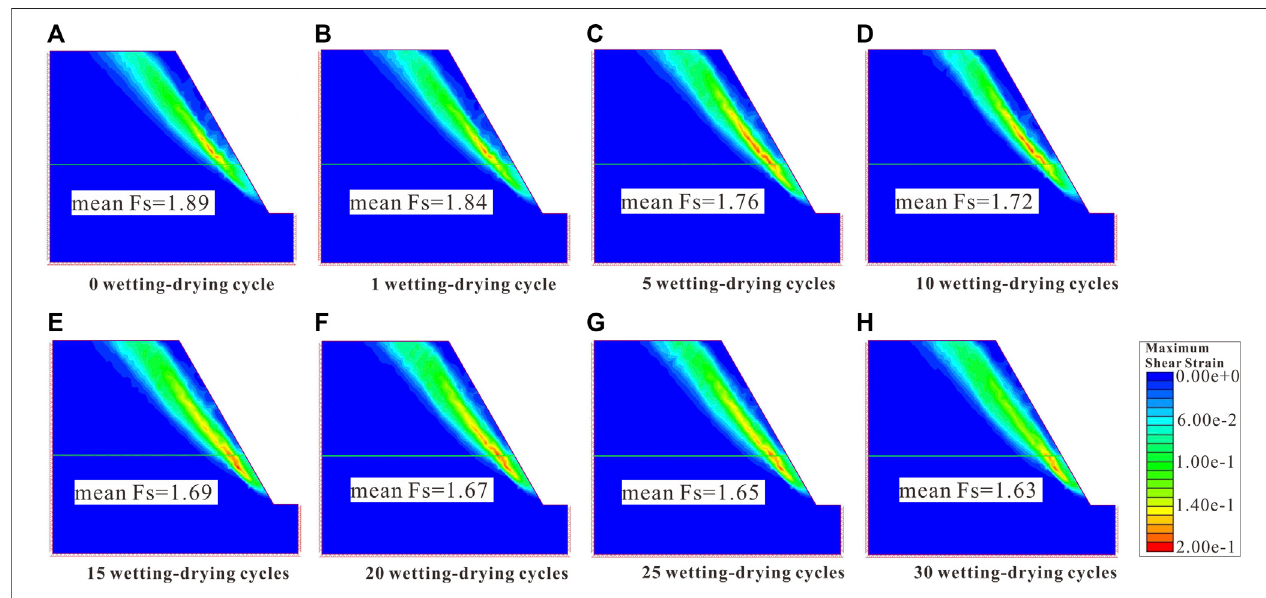
FIGURE 3 | Plots of the shear strain of the slope using the strength reduction method with mean Fs: (A) before wetting – drying cycling; (B) after 1 wetting – drying cycle; (C) after 5 wetting – drying cycles; (D) after 10 wetting – drying cycles; (E) after 15 wetting – drying cycles; (F) after 20 wetting – drying cycles; (G) after 25 wetting – drying cycles; (H) after 30 wetting – drying